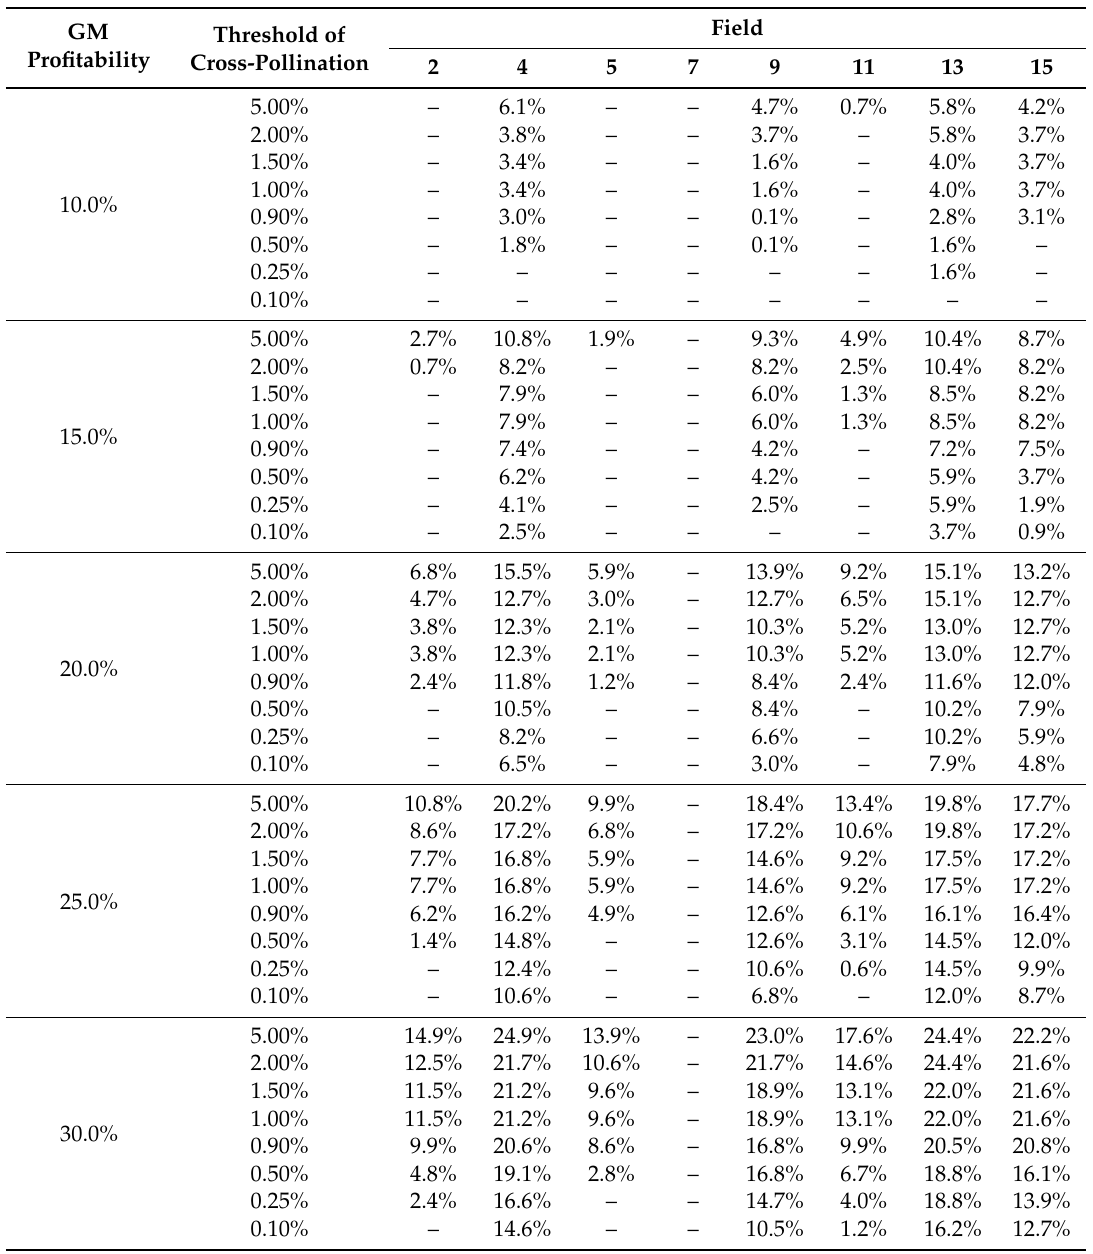
Table 6. Percentage profits relative to the baseline GM crop profits at the field level as a function of increasing profitability for the GM crop in comparison to the non-GM crop and thresholds of cross-pollination when non-GM producers have the property rights. There is heterogeneity in the profits of GM fields because heterogeneous amounts of buffer are created in the GM fields. The GM fields include 2, 4, 5, 7, 9, 11, 13, and 15. The economic unsuitability of a field for the GM crop (i.e., losses due to the buffer) is represented by dashes in the